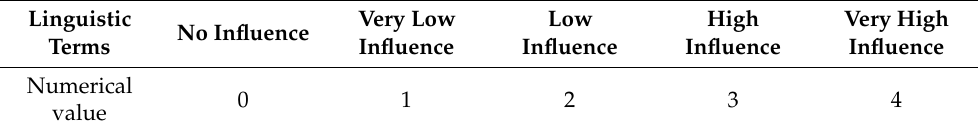
Table 4. The correspondence of DEMATEL